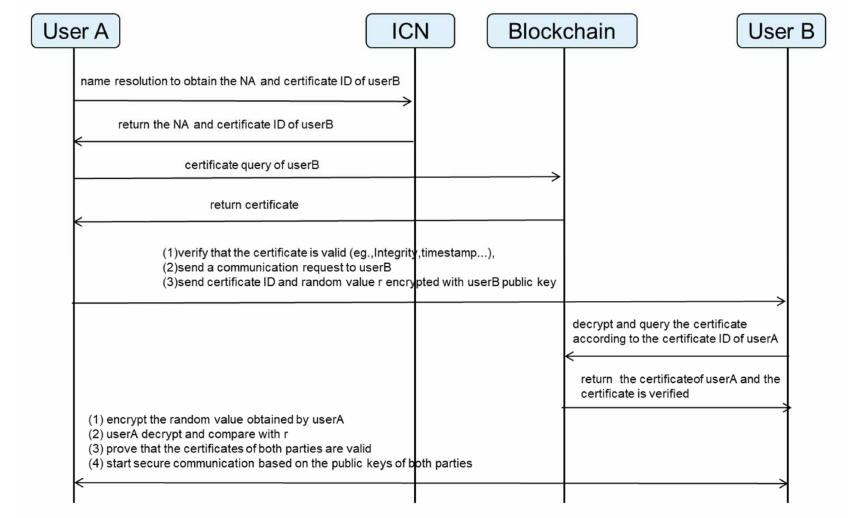
Figure 6. The process of the secure